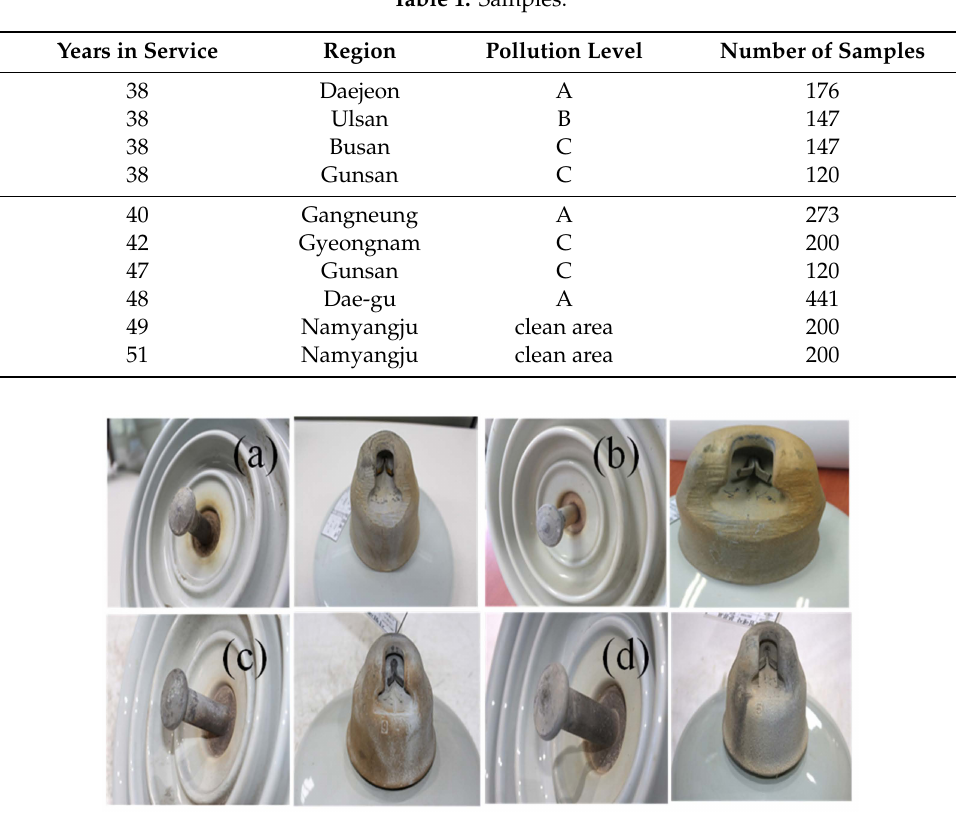
Figure 2. Appearance of pins and caps of porcelain insulators used for ( a ) 38 years in Daejeon, ( b ) 40 years in Gangneung, ( c ) 48 years in Dae-gu, and ( d ) 51 years in Namyangju.